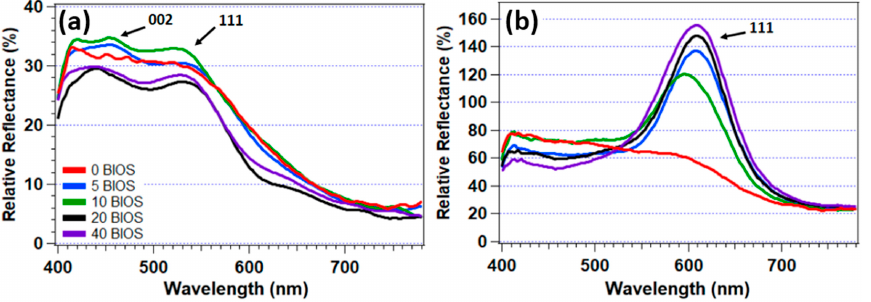
Figure 5. Spectroscopic data of relative reflectance for polymer opals of 0–40 BIOS passes from the viewing angles ( a ) θ m = 70° and ( b ) θ m = − 10°, with the peaks originating from the {002} and {111} planes